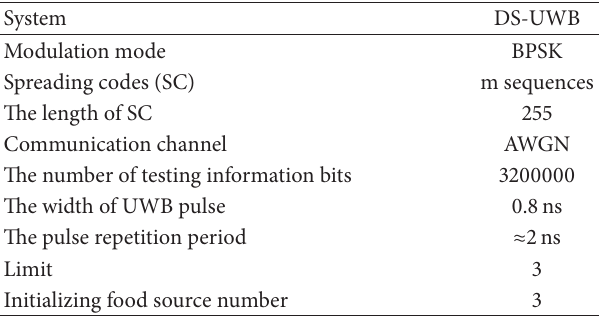
Table 1: Simulation